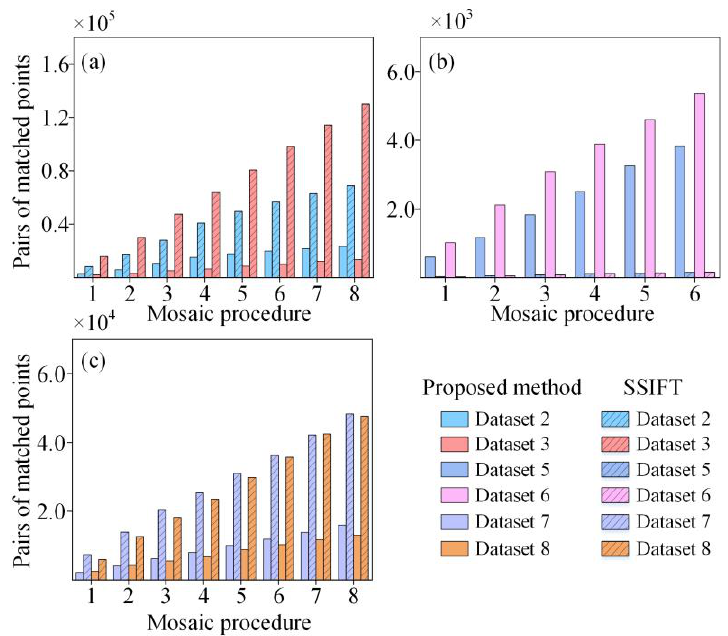
Figure 7. Cumulative numbers of feature points for rice UAV images processed using SSIFT and proposed method without deleting the mismatched points. ( a ), ( b ), and ( c ) are the cumulative numbers of matched feature points for the visible, thermal infrared, and near-infrared UAV images of rice, respectively.